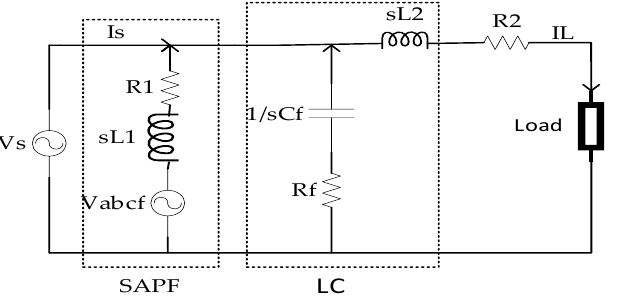
Figure 2. Equivalent circuit of the LCL-HPF filter.